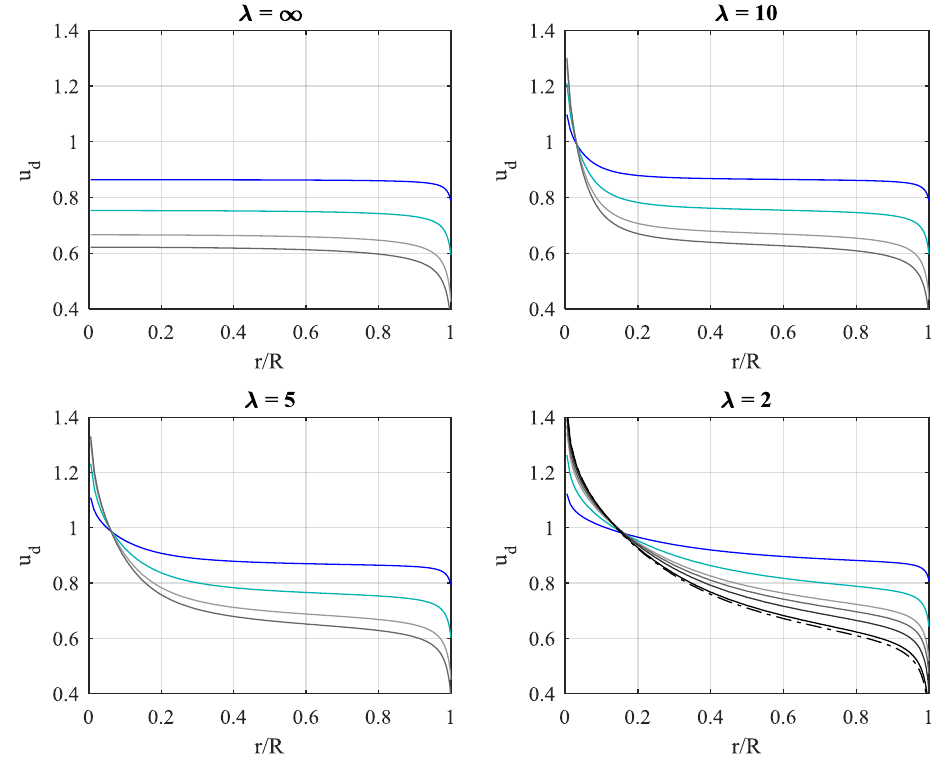
Figure 5. AD results: Radial distribution of normalized axial flow velocity through the rotor, 𝑢 𝑑 , for different levels of rotor loading (color code, see Table 1) and tip-speed ratio 𝜆 .